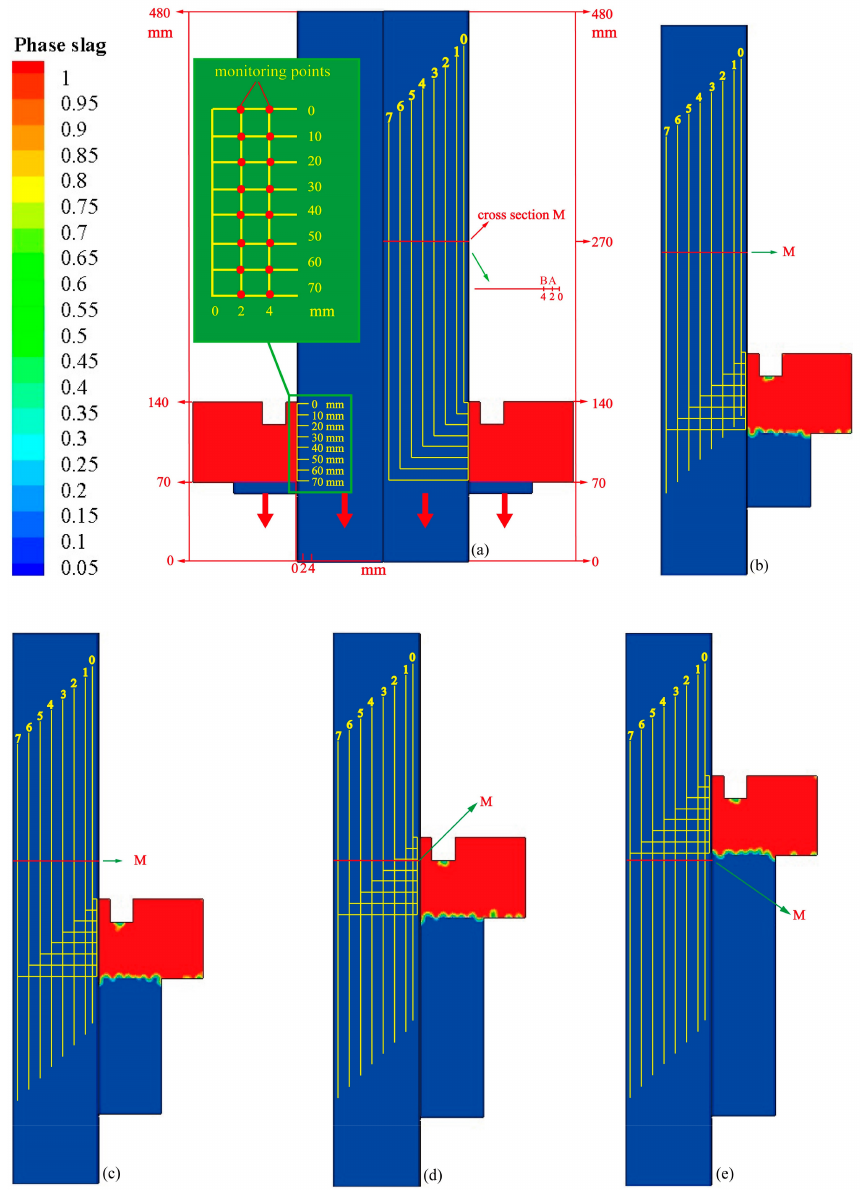
Figure 6. Phase of slag at different times: ( a ) 120 s; ( b ) 720 s; ( c ) 1320 s; ( d ) 1920 s; ( e ) 2520